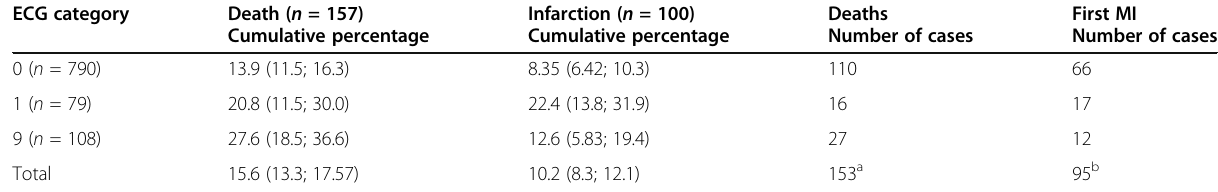
Table 3 Estimated cumulative incidences (percentages) and absolute numbers of deaths and first MI for participants followed for 25 years by category (95% confidence intervals in brackets)